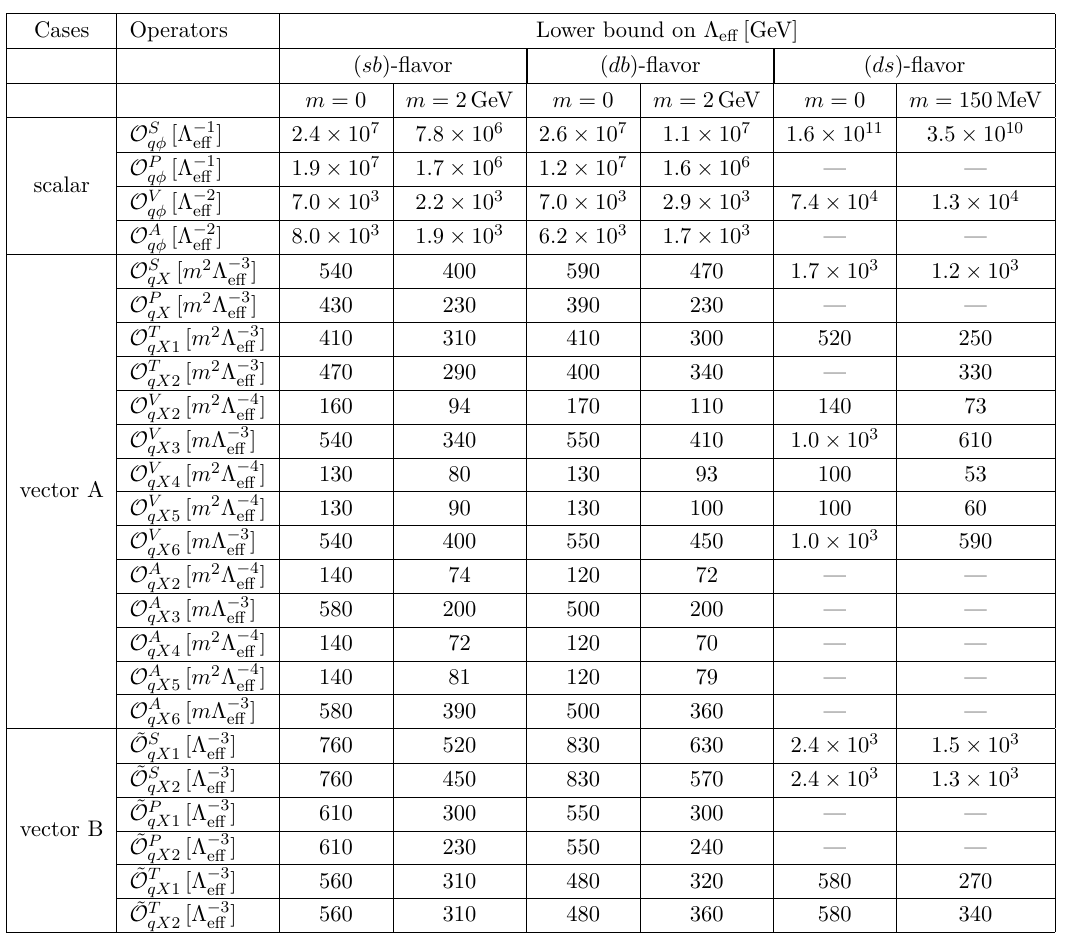
Table 3 . The strongest bounds on the effective scale Λ eff associated with all FCNC operators with two representative DM masses: m = 0 and m = 2 GeV (or m = 150 MeV for ( ds ) - flavor). For the ( ds ) -flavor, all the constraints in the table come from the charged channel K + → π + /E .